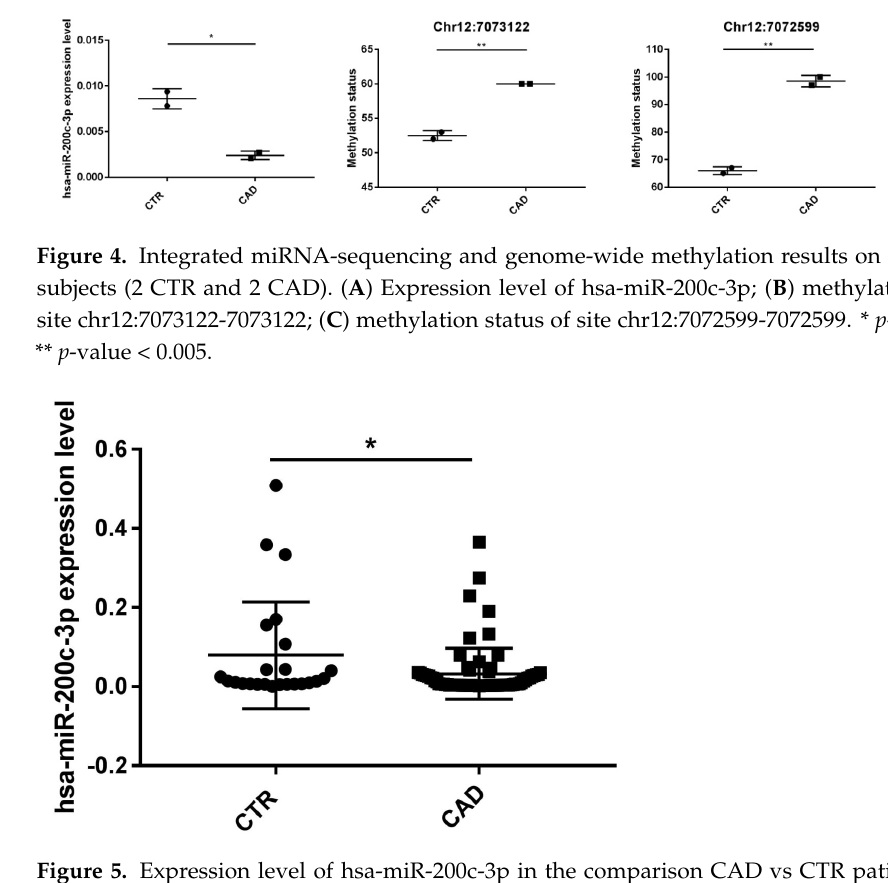
Whitney test. * p -value < 0.05. Expression data are represented as the mean and SD. Figure 5. Expression level of hsa-miR-200c-3p in the comparison CAD vs CTR patients. Mann–Whit-